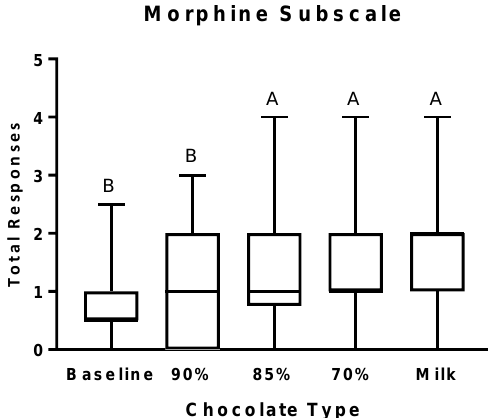
Figure 3. Morphine (M) subscale scores after the consumption of chocolates differing in cocoa, sugar, and fat content. Self-reported scores on the M subscale are presented as box and whiskers plots with the line representing the median, the box representing the 25th to 75th percentiles, and the whiskers representing the minimum to maximum values. Least-squares means are Baseline: 0.78 ± 0.20 (SE), 95% CI [0.37, 1.19]; 90% cocoa: 1.00 ± 0.19 (SE), 95% CI [0.62, 1.38]; 85% cocoa: 1.47 ± 0.19 (SE), 95% CI [1.09, 1.84]; 70% cocoa: 1.57 ± 0.19 (SE), 95% CI [1.19, 1.94]; Milk: 1.57 ± 0.19 (SE), 95% CI [1.19, 1.94]. Levels not connected by the same letter are significantly different.